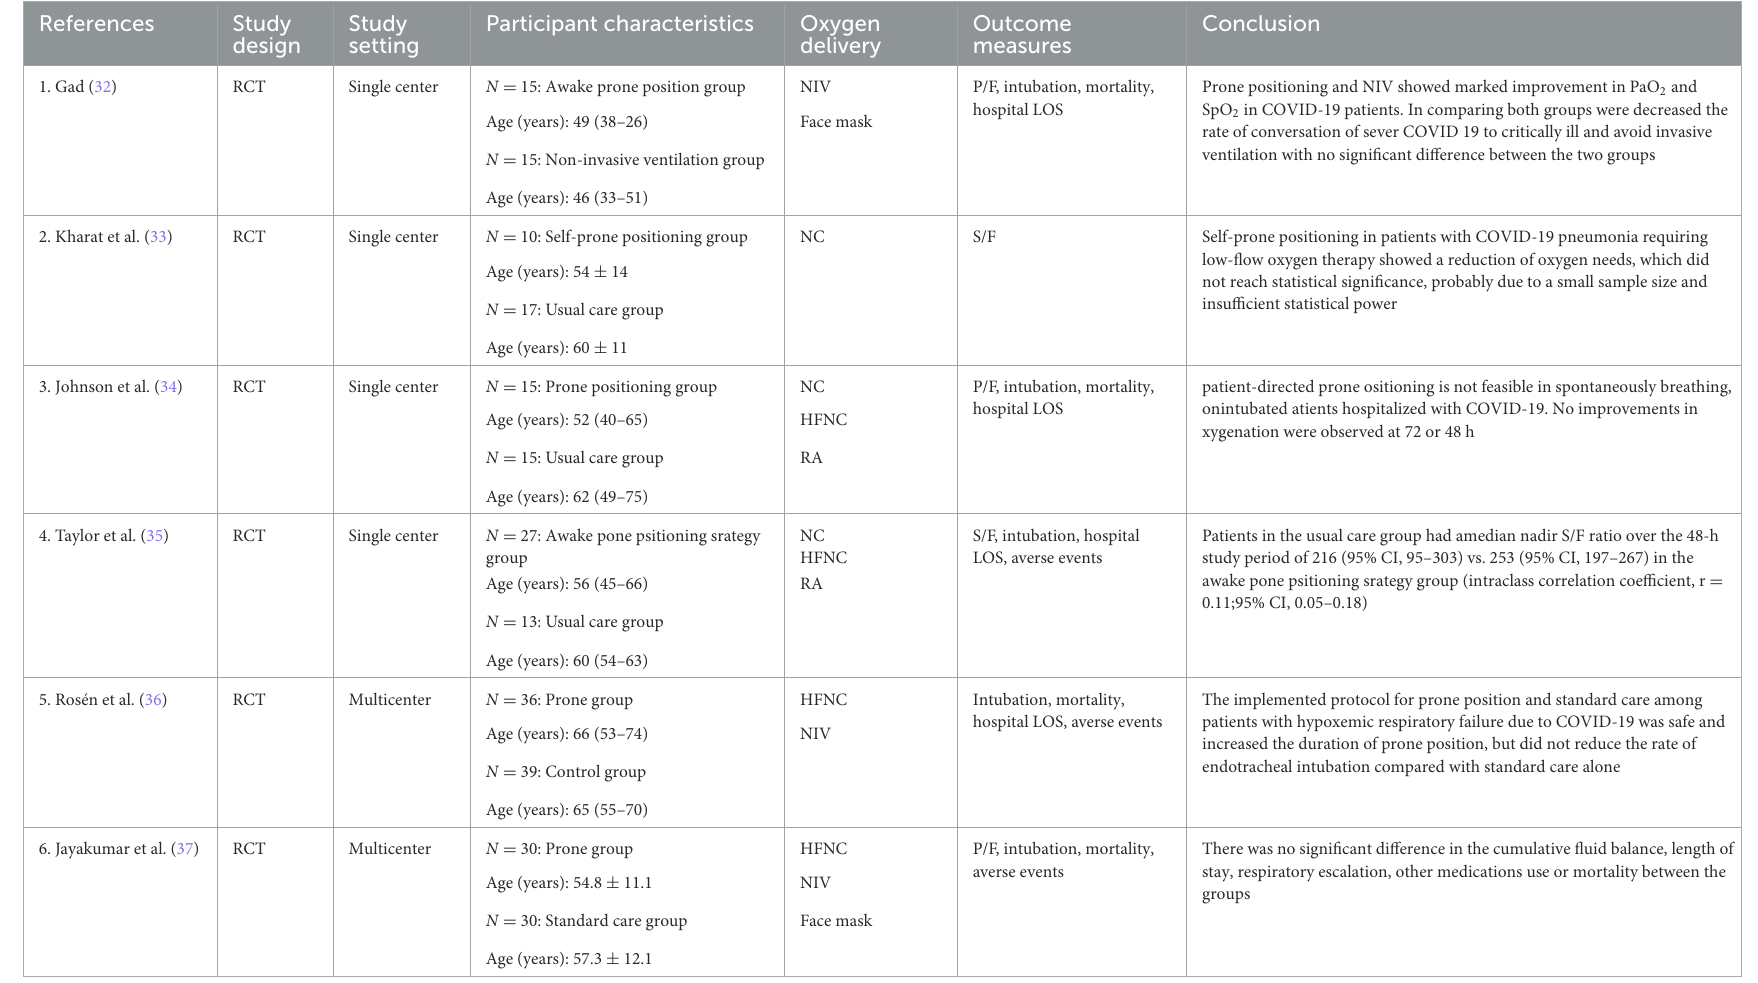
TABLE 1 Baseline characteristics of included